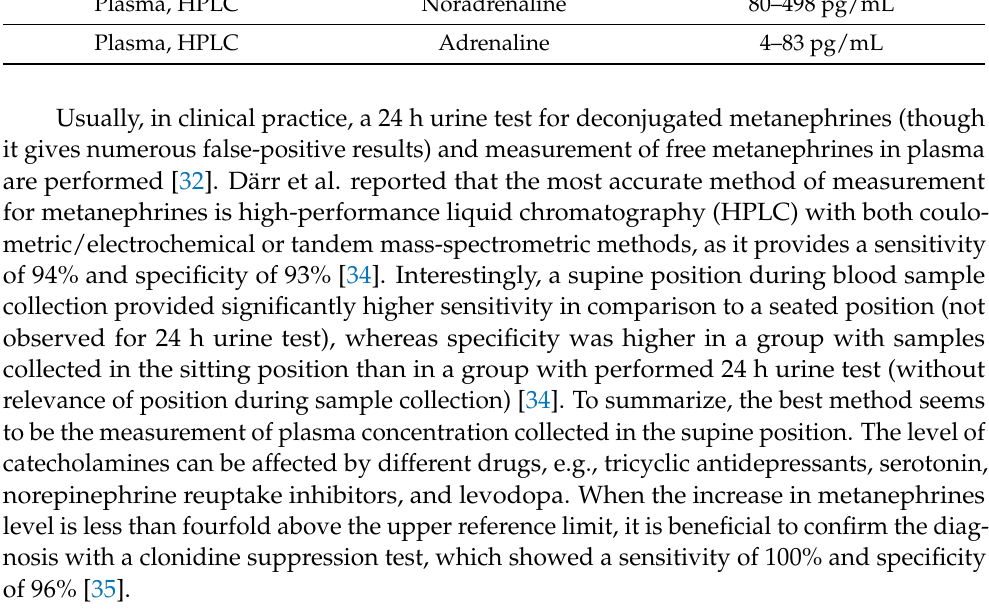
Table 3. Biochemical diagnosis of PGL tumors; HPLC—high-performance liquid chromatography. Example of a Reference Recommended Material and Catecholamine Norm Method 24 h urine test, HPLC Noradrenaline Adrenaline spectrophotometrically